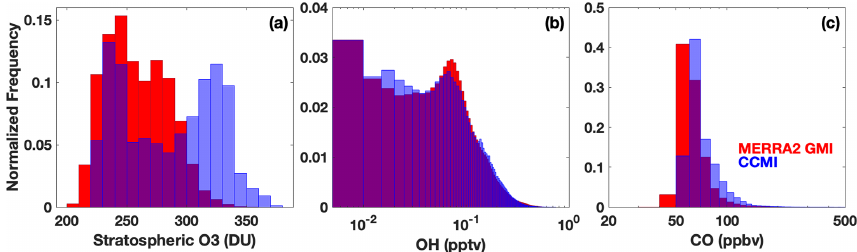
Figure 12. Histograms showing the distribution of stratospheric column O 3 (a) , tropospheric OH (b) , and tropospheric CO (c) from the M2GMI-monthly parameterization training dataset (red) and from the CCMI simulation for 2060 (blue). Purple indicates areas of overlap between the two